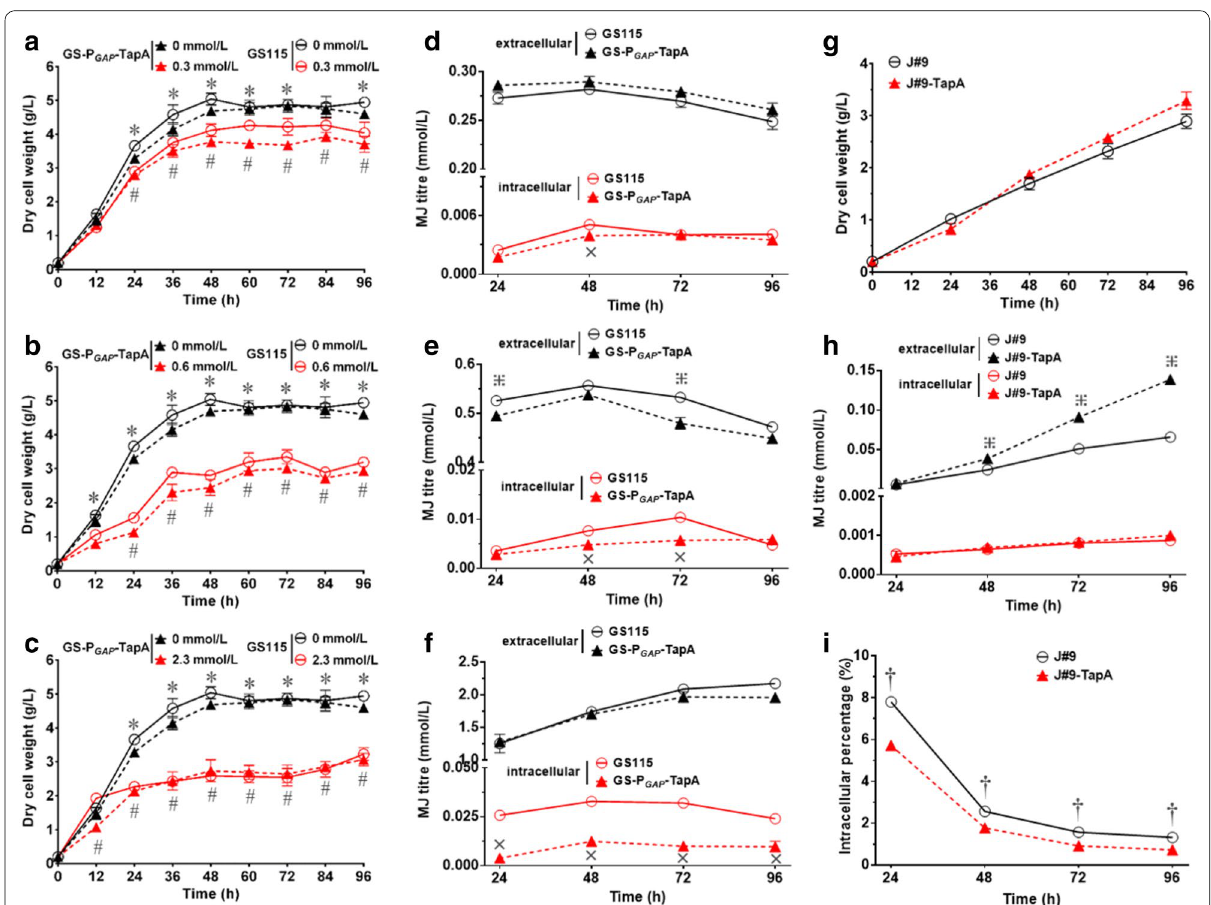
Fig. 3 TapA function analysis by MJ distribution of various constructed strains. Dry cell weight of GS-P GAP -TapA and wild-type GS115 fed with MJ of 0.3 mmol/L ( a ), 0.6 mmol/L ( b ) and 2.3 mmol/L ( c ) in shake flask. Extracellular and intracellular MJ levels of GS-P GAP -TapA and GS115 fed with MJ of 0.3 mmol/L ( d ), 0.6 mmol/L ( e ) and 2.3 mmol/L ( f ) in shake flask. Dry cell weight ( g ), extracellular and intracellular MJ ( h ) and intracellular MJ percentage ( i ) of J#9-TapA and J#9 in shake flask. Three replicates were tested and experiments were conducted three times. Statistical significance was analyzed for each comparative group at various time points. * P < 0.05 for cell growth of GS115 relative to GS115 with MJ feeding. # P < 0.05 for cell growth of GS-P GAP -TapA relative to GS-P GAP -TapA with MJ feeding. × P < 0.05 for intracellular MJ of GS115 relative to that of GS-P GAP -TapA. ⁜ P < 0.05 for extracellular MJ of J#9 relative to that of J#9-TapA. † P < 0.05 for intracellular percentage of MJ of J#9 relative to that of J#9-TapA. Data with not significant differences were not marked in figure. Error bars smaller than the plot symbols were not displayed by the GraphPad